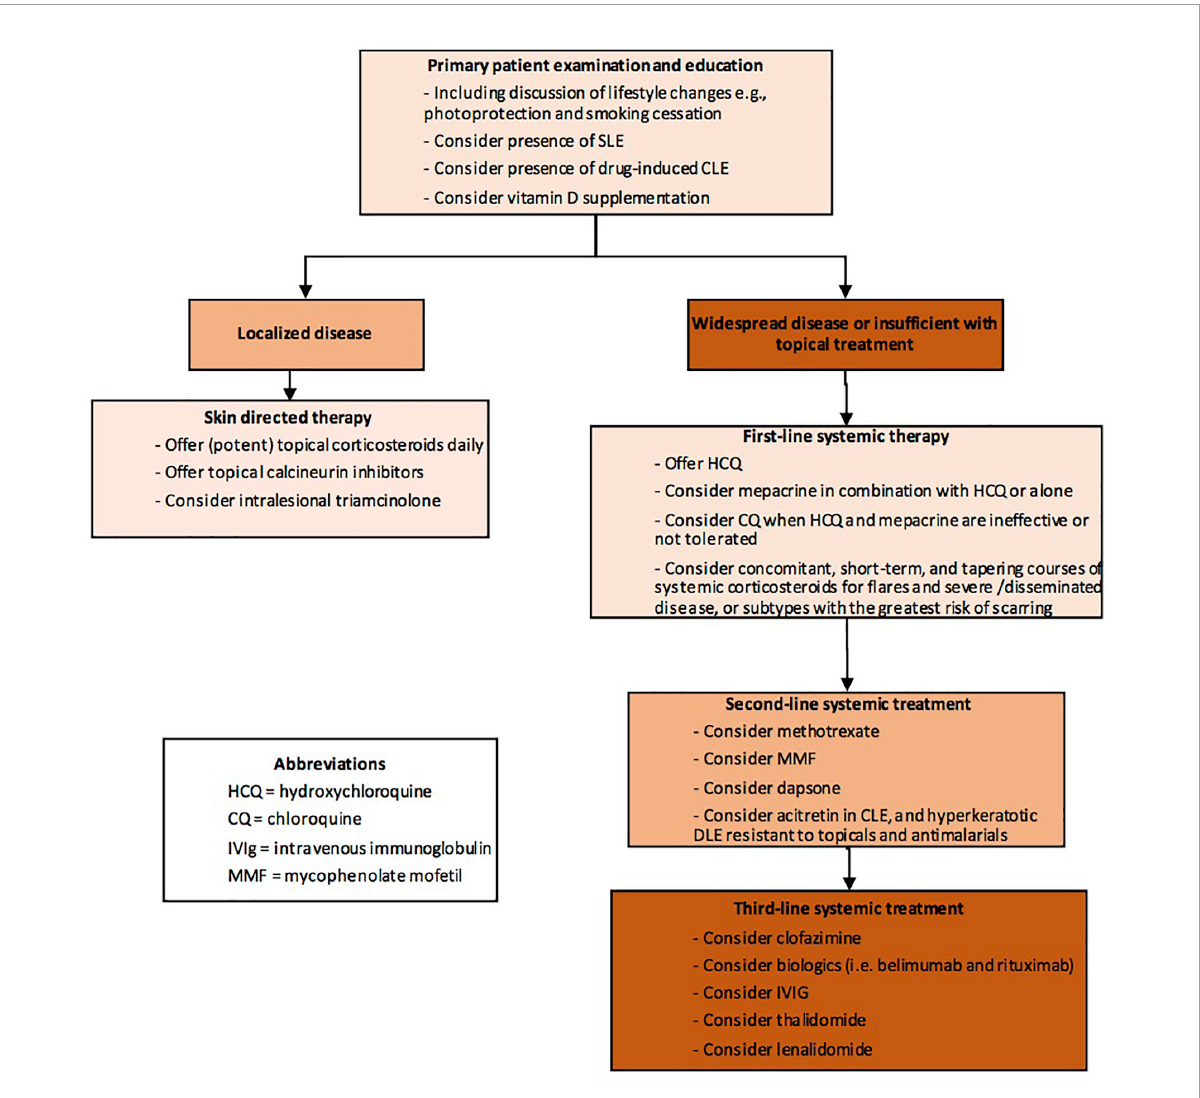
FIGURE1 Patient management pathway Cutaneous Lupus Erythematosus (abbreviated) from Wiley Library © 2021 British Association of Dermatologists (119).